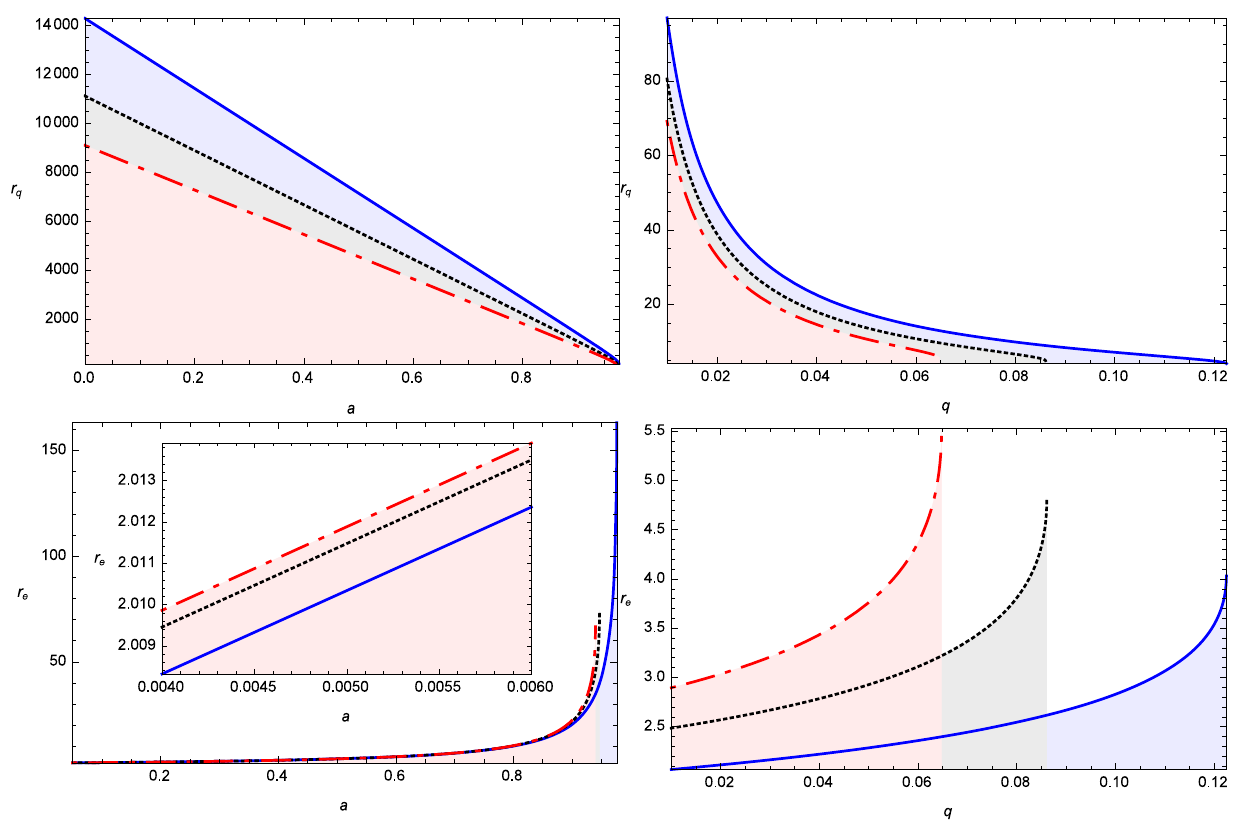
a = 0 . 01 (blue), a = 0 . 17 (black), and a = 0 . 28 (red). The left panel of the second row represents q = 0 . 00007 (blue), q = 0 . 00009 (black), and q = 0 . 00011 (red). The right panel of the second row represents